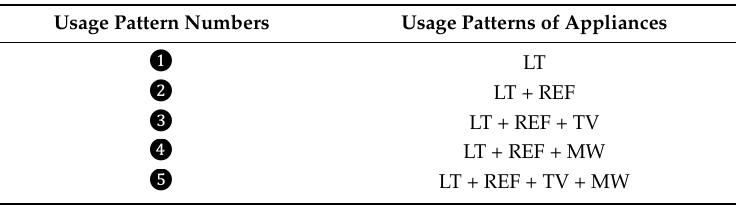
0.001.002.003.00